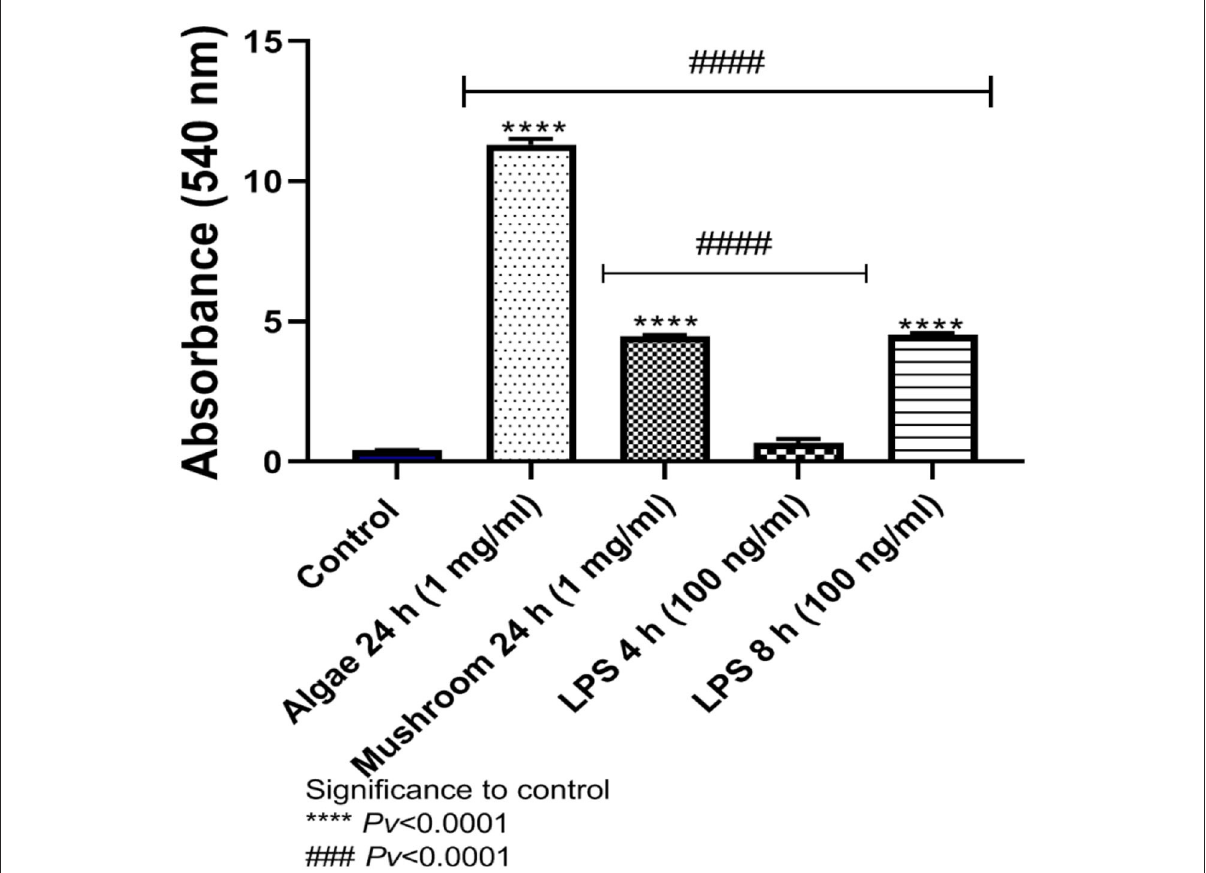
FIGURE5 Release of NO to the medium after exposure to algae or mushrooms beta-glucans glucans for 24h, or LPS. ****Pv < 0.0001 significance to control group. ### Pv < 0.0001 significance between beta-glucans to LPS for 4 and 8h (n =